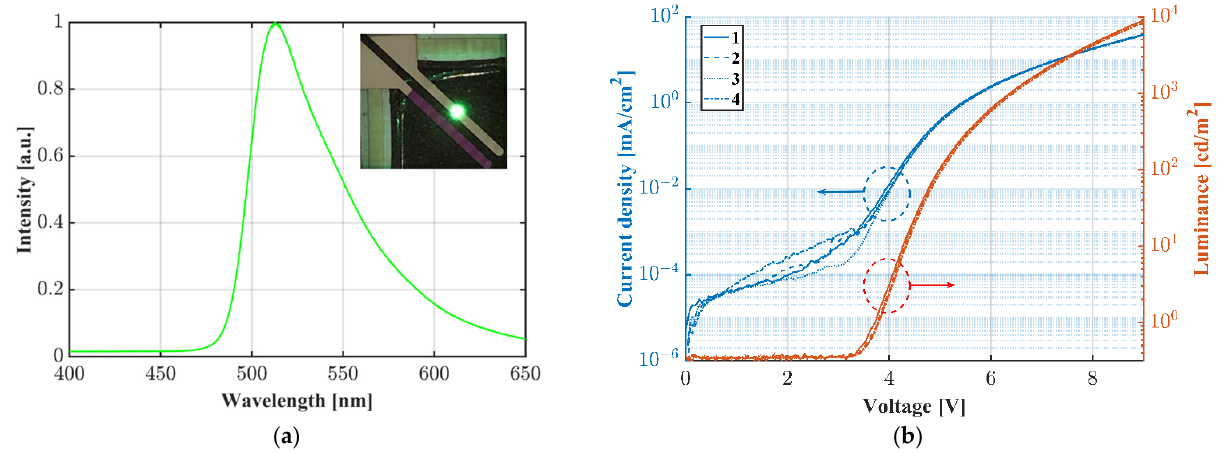
Figure 3. ( a ) Normalized spectrum of the green emitting (peaking at ~512 nm) Ir(mppy) 3 OLED as an example; ( b ) current density and luminance vs. voltage characteristics of the fabricated bottom- emitting OLED.